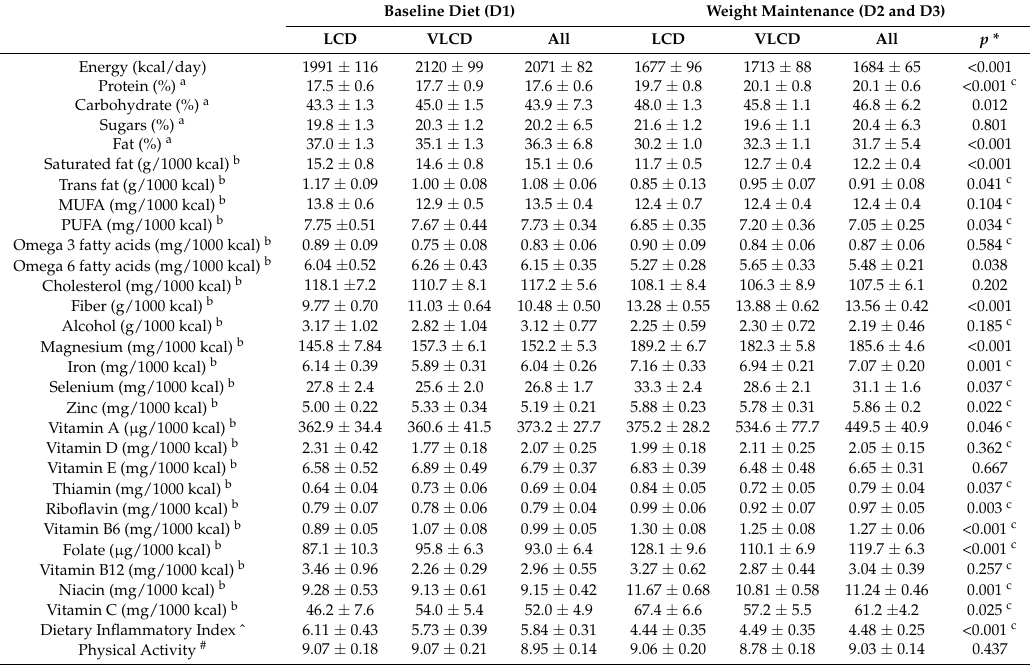
Table 2. Dietary intake and physical activity at baseline and during weight maintenance in the LCD and VLCD groups and both groups combined